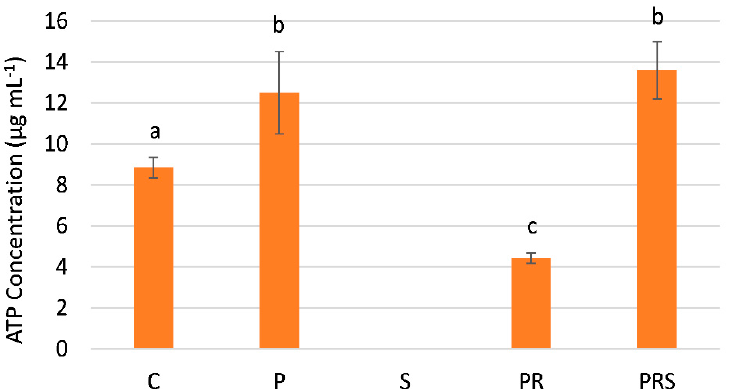
Figure 6. ATP concentration in control sample (C); primed sample (P); stressed sample (S); primed and recovered sample (PR); primed, recovered and stressed sample (PRS). Averages ± standard deviation of three experiments analyzed in triplicate are reported. Averages were compared by one-way ANOVA. Bars marked with the same letter are not significantly different ( p ≥ 0.05).